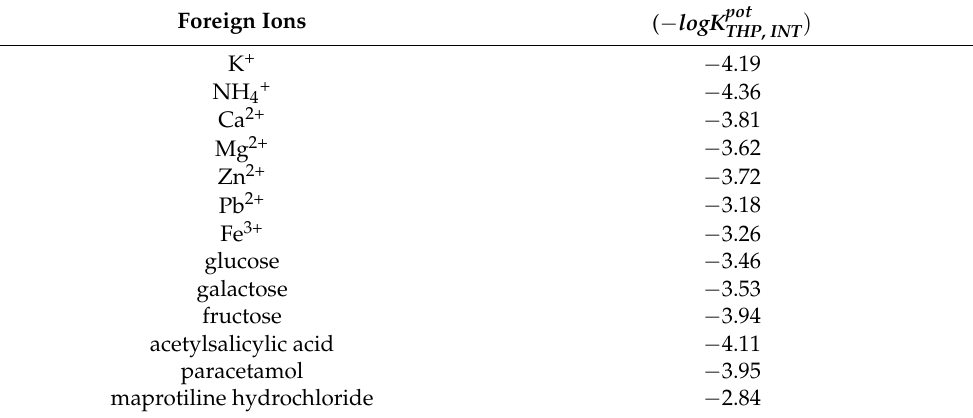
) of various ions for proposed THP, INT